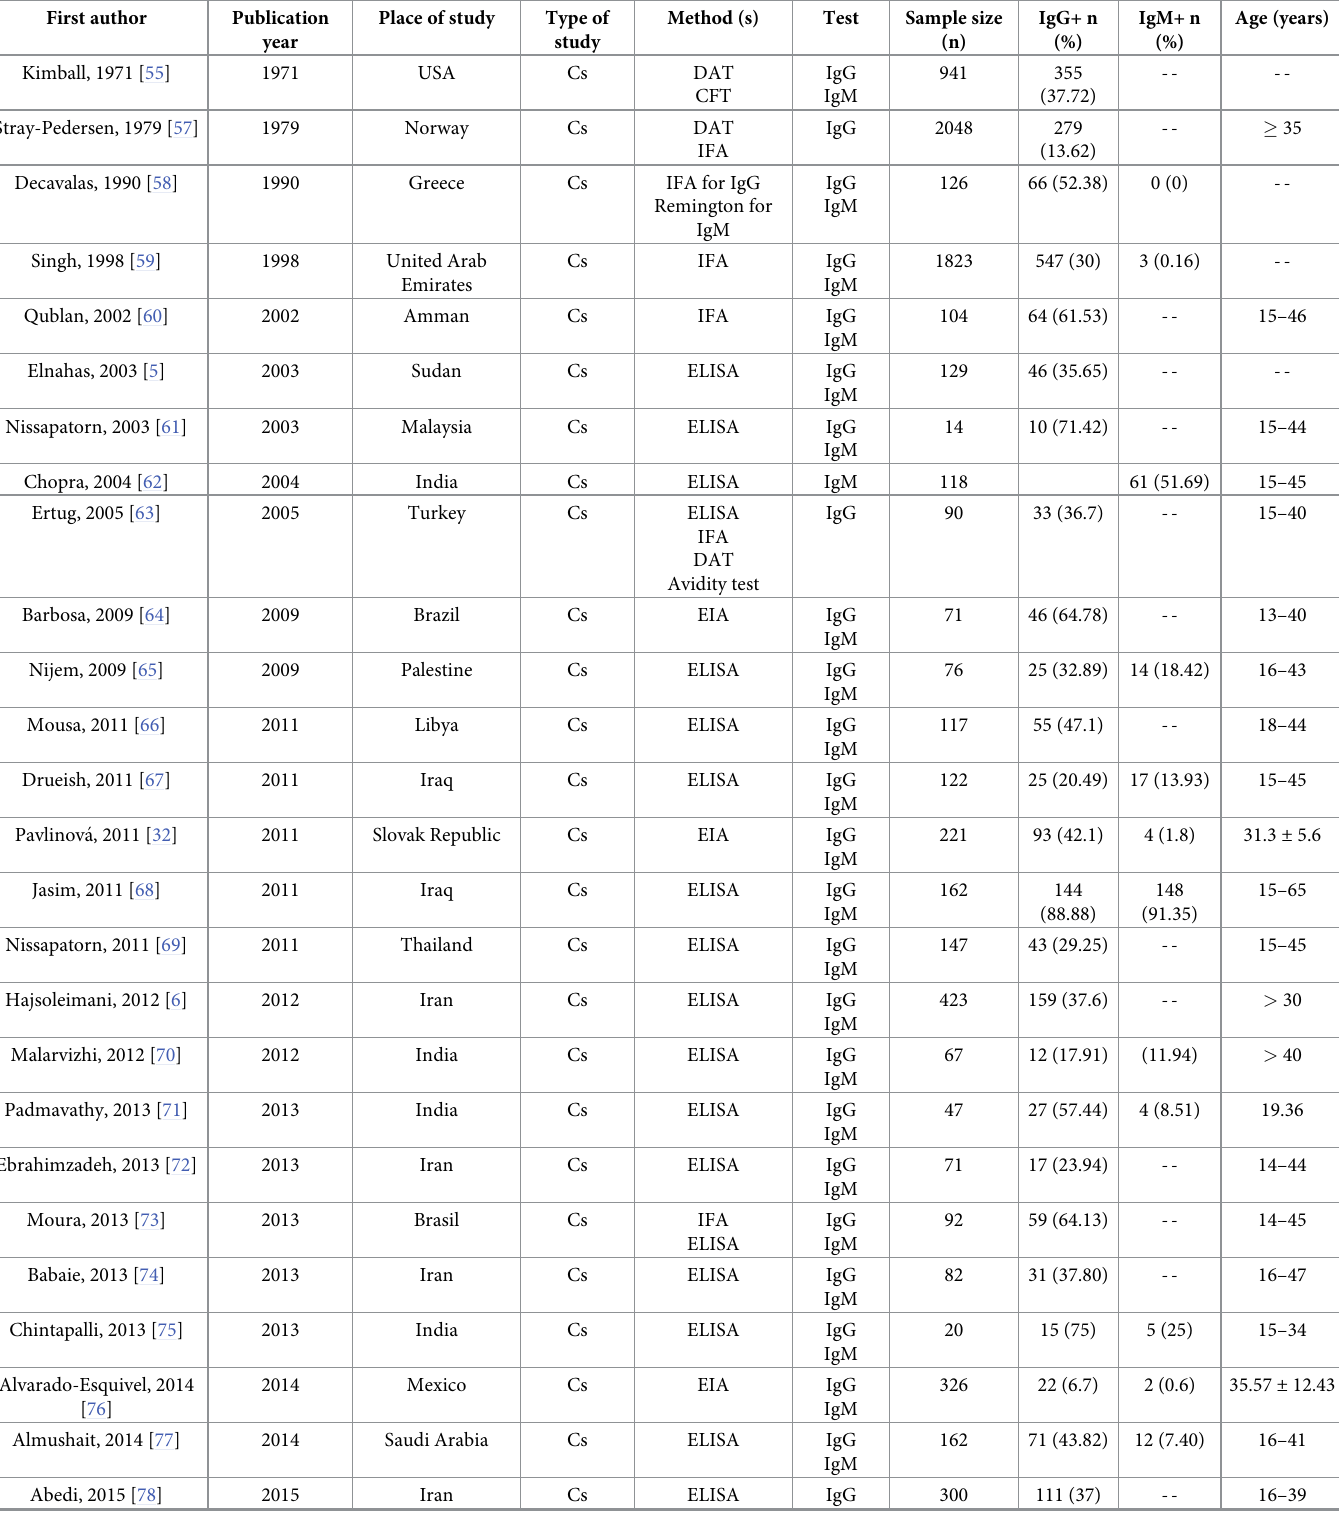
Table 1. Characteristics of the included studies for seroprevalence of anti- T . gondii antibodies in women who had a history of